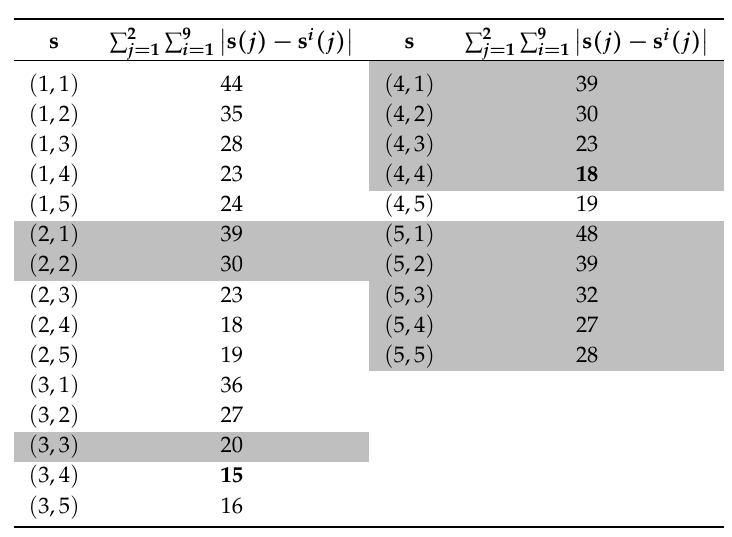
Table 2. Sum of distances between the scores provided by the panelists and all possible vectors of scores. The minimizers are shown in bold, and the vectors of scores in which the first sample is assigned a score greater than or equal to the score of the second sample are highlighted in